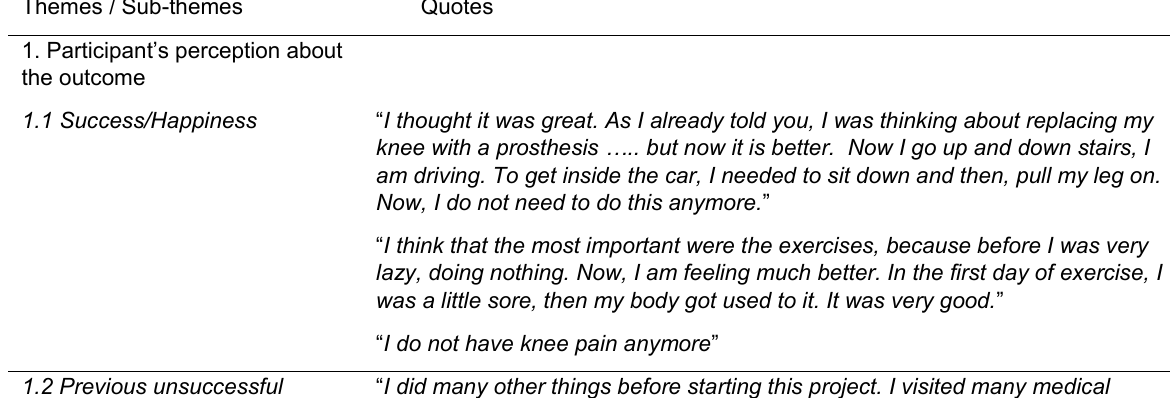
Post Intervention Focus Group Qualitative